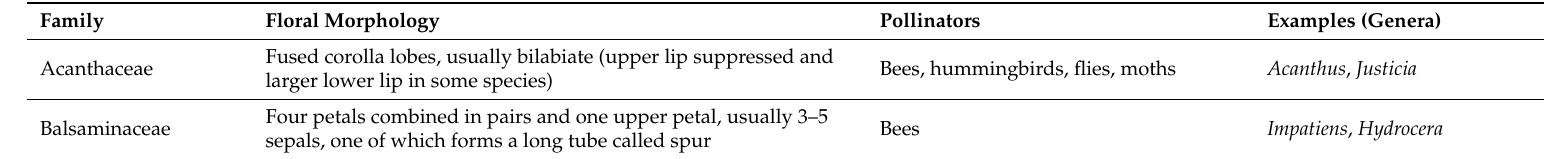
Figure 1. Examples of complex morphologies of flowers. ( a ) Tecoma stans (Bignoniaceae); ( b ) Angaecum sesquipedale (Orchidaceae); ( c ) Impatiens balsamina (Balsaminaceae); ( d ) Lupinus pilosus (Fabaceae); ( e ) Ophrys alasiatica (Orchidaceae); ( f ) Salvia hierosolymitana (Lamiaceae); ( g ) Iris atropurpurea (Iridaceae); ( h ) Zingiber officinale (Zingiberaceae); ( i ) Calceolaria crenatiflora (Calceolariaceae); ( j ) Antirrhinum majus (Plantaginaceae). Photographers: ( a ) Calvin Finch; ( b ) Karole Schon; ( d , i ) Judith Marcus; ( e ) Michael Pettemerides; ( f ) Gideon Pisanty; ( g ) Ada Knossow; ( h ) Alastair Culham; ( j ) George Konstantinu. Table 2. Features of morphological complexity in flowers of selected plant families.